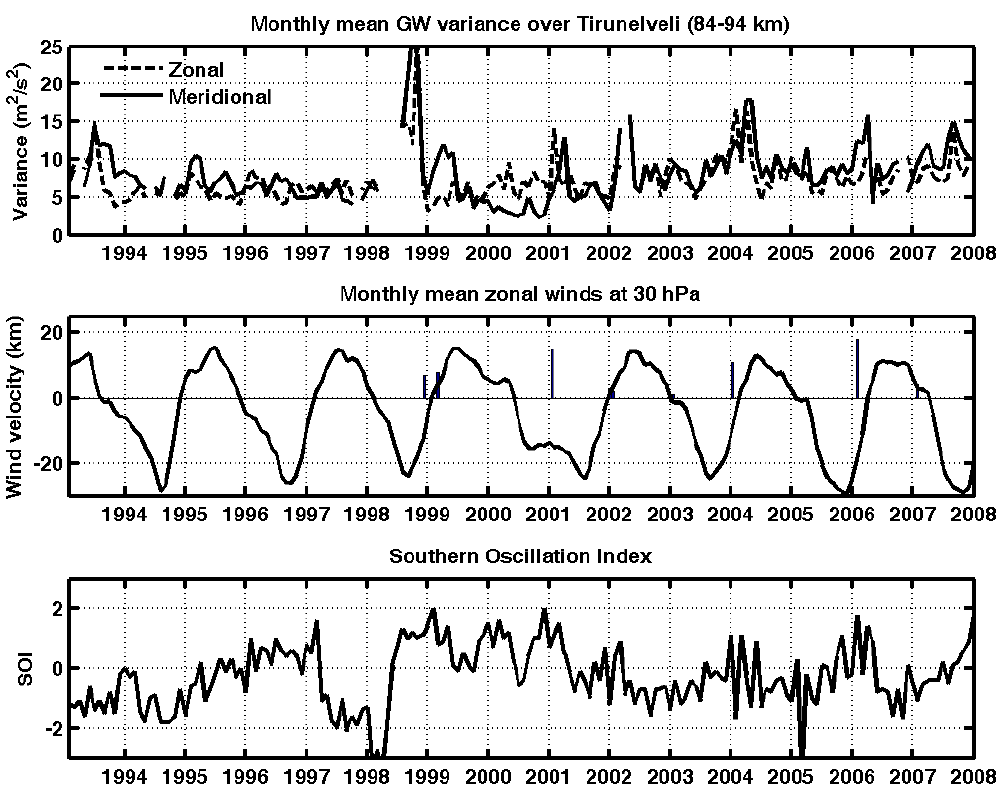
Fig. 3. Monthly mean gravity wave variances in zonal and meridional winds (top panel), zonal averaged stratospheric QBO winds at 30hPa (middle panel) and Southern Oscillation Index (bottom panel). The bars in the middle panel shows the occurrence time of major stratospheric warming events and the height of the bar shows duration of the event in days. Table 1. Major stratospheric warming events, their duration and magnitude of wind reversal. Sl. No. Sudden stratospheric warming dates Duration Magnitude of wind (days) reversal at 60 ◦ N (m/s) 1 7